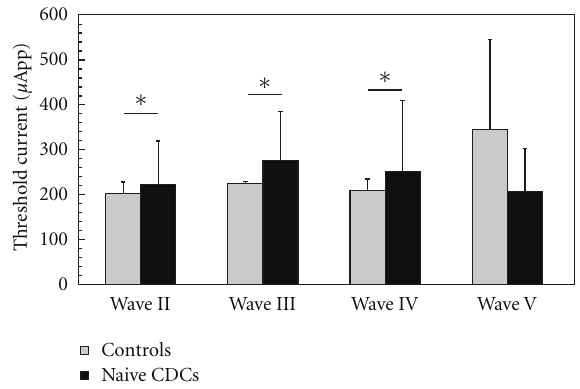
Figure 5: Comparisons of wave thresholds in matured animals (older than 3 months). Significantly larger thresholds were observed in CDCs for waves II, III, and IV. The trend in wave V is in opposite direction (two-tailed t -test at α = 5%).